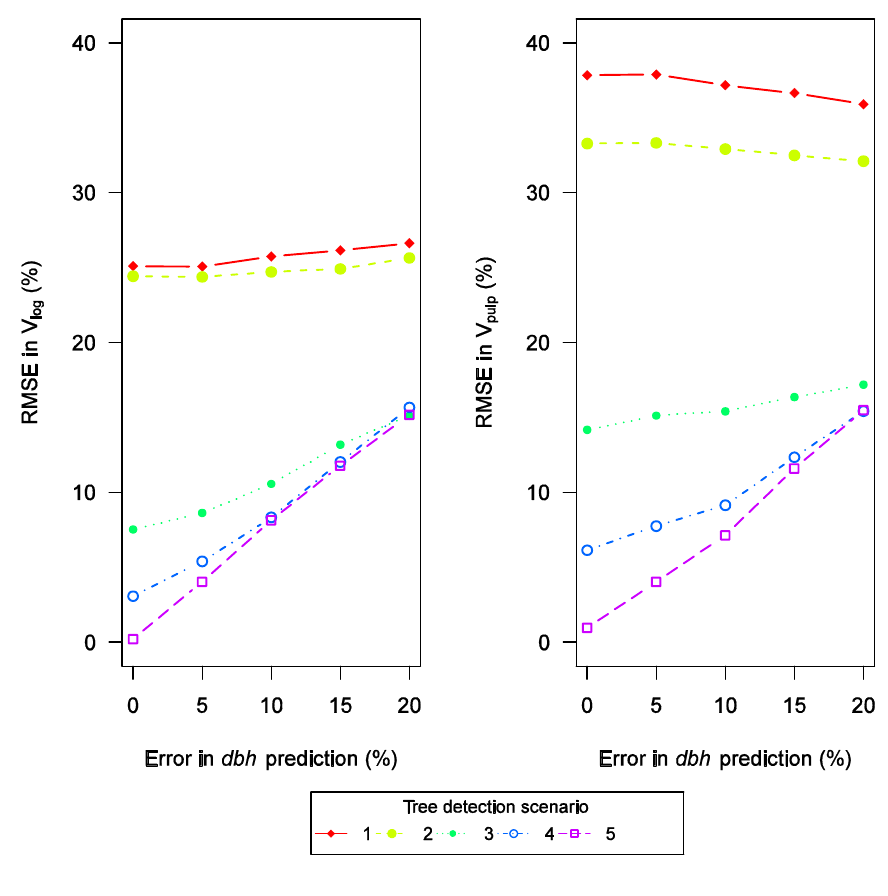
Figure 3. Combined effects of dbh prediction and tree detection on the stand log wood (left) and pulp wood (right)